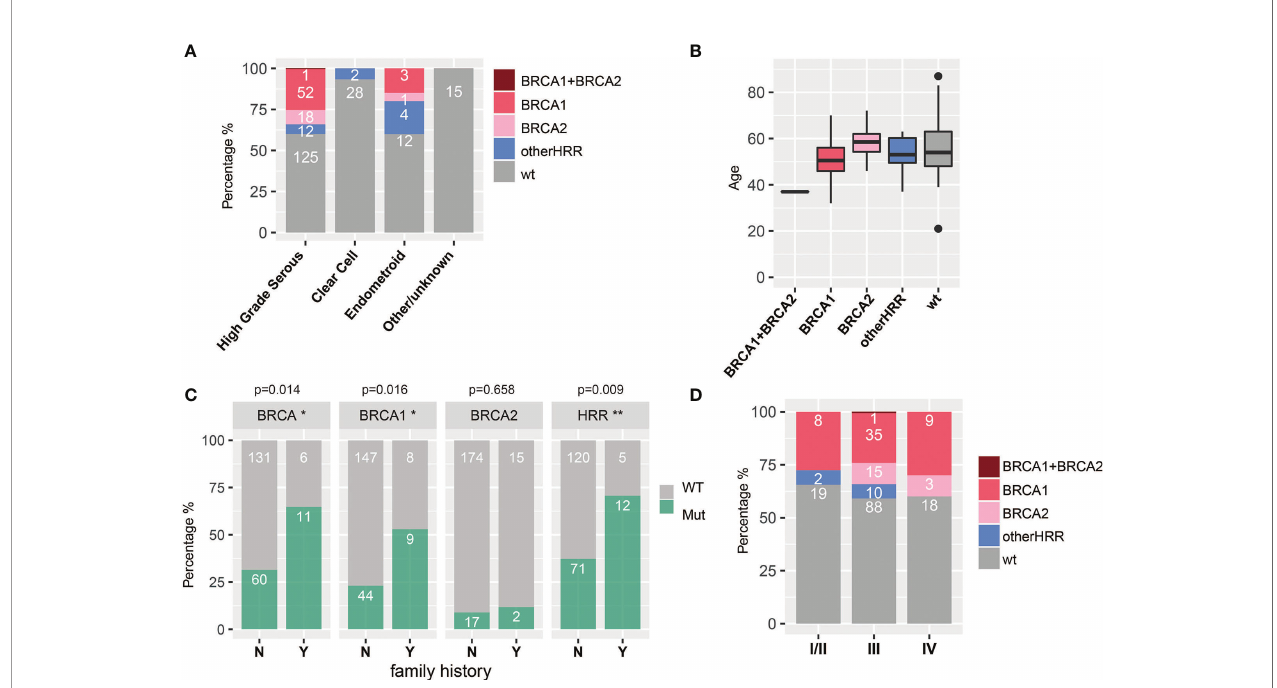
FIGURE 4 | Associations between HRR mutations and histopathologic (A) subtypes, (B) age, (C) family history and multiple primary foci (Y means cases with family history or multiple primary foci, and N means none; * means signi fi cant difference between mutation of that gene and multiple primary foci or family history), and (D)